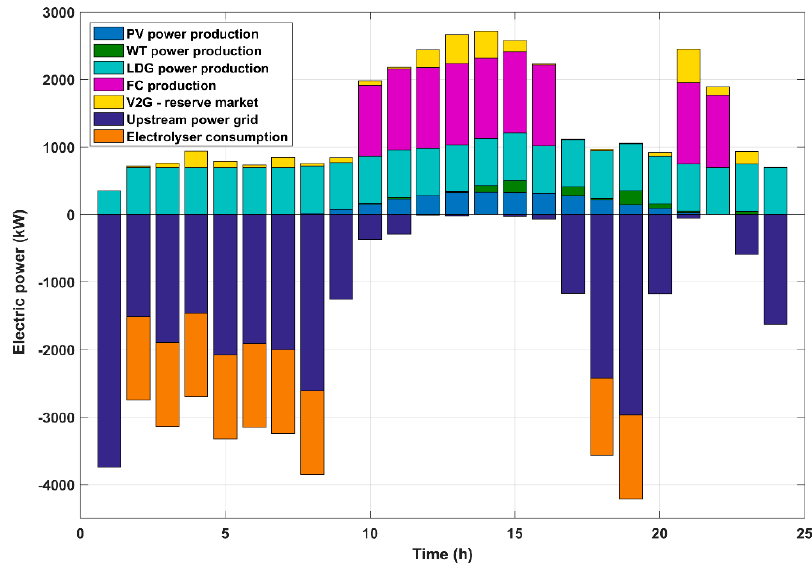
Figure 7. Optimal electric power dispatching results obtained in Case Study 2.